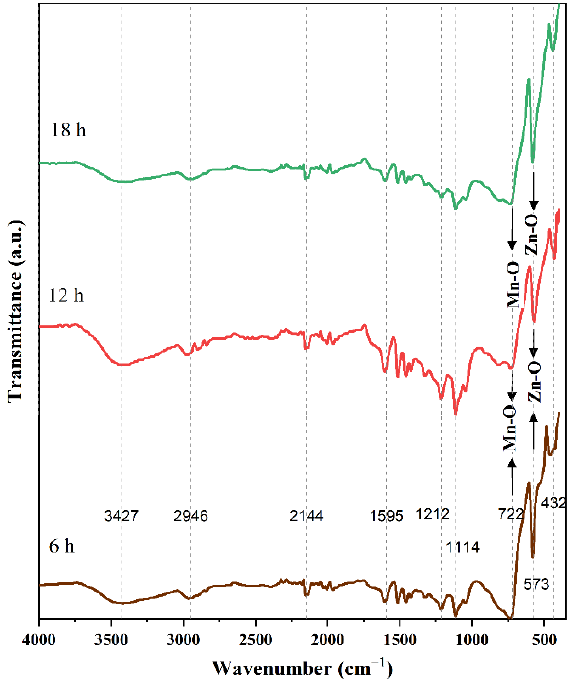
5 of 17 Table 1. Calculated lattice parameters for ZnMn 2 O 4 spinel samples.